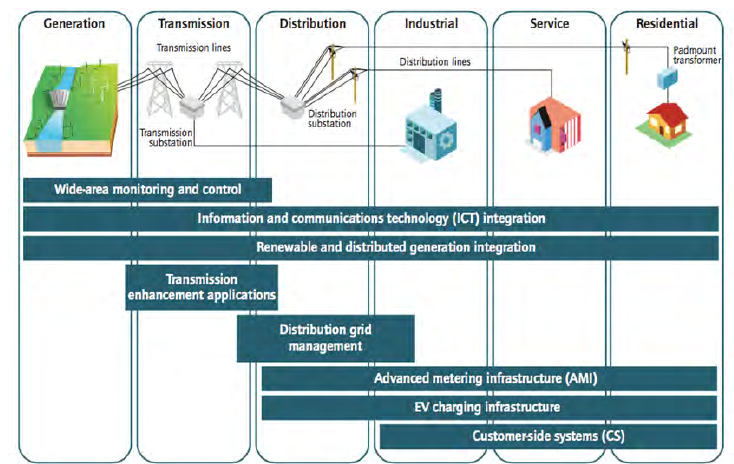
Figure 3. Smart grid technology areas, adapted from (International Energy Agency, 2011).